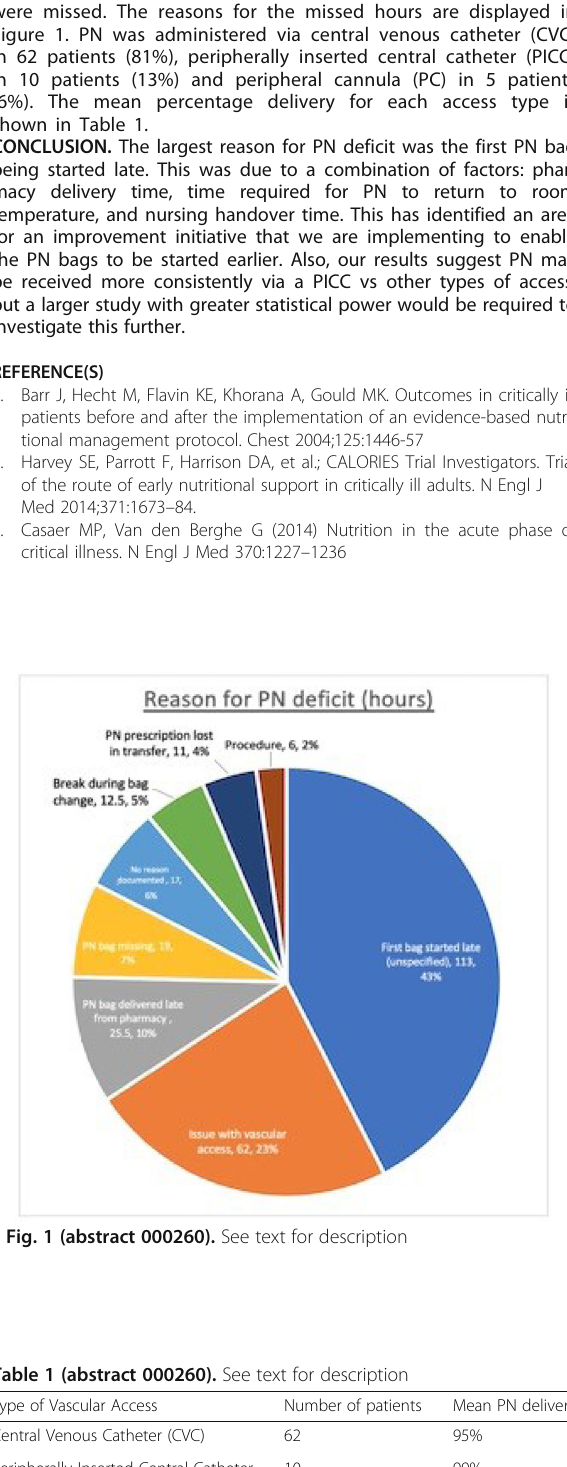
Figure 1. PN was administered via central venous catheter (CVC) in 62 patients (81%), peripherally inserted central catheter (PICC) in 10 patients (13%) and peripheral cannula (PC) in 5 patients (6%). The mean percentage delivery for each access type